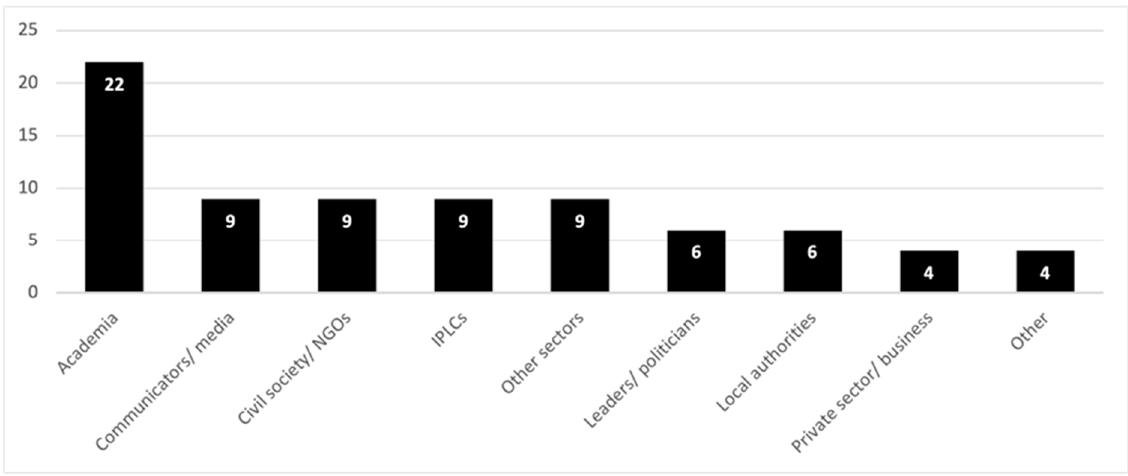
Figure 5. Key actors considered, by respondents to the survey, to be missing from the science-policy interface.